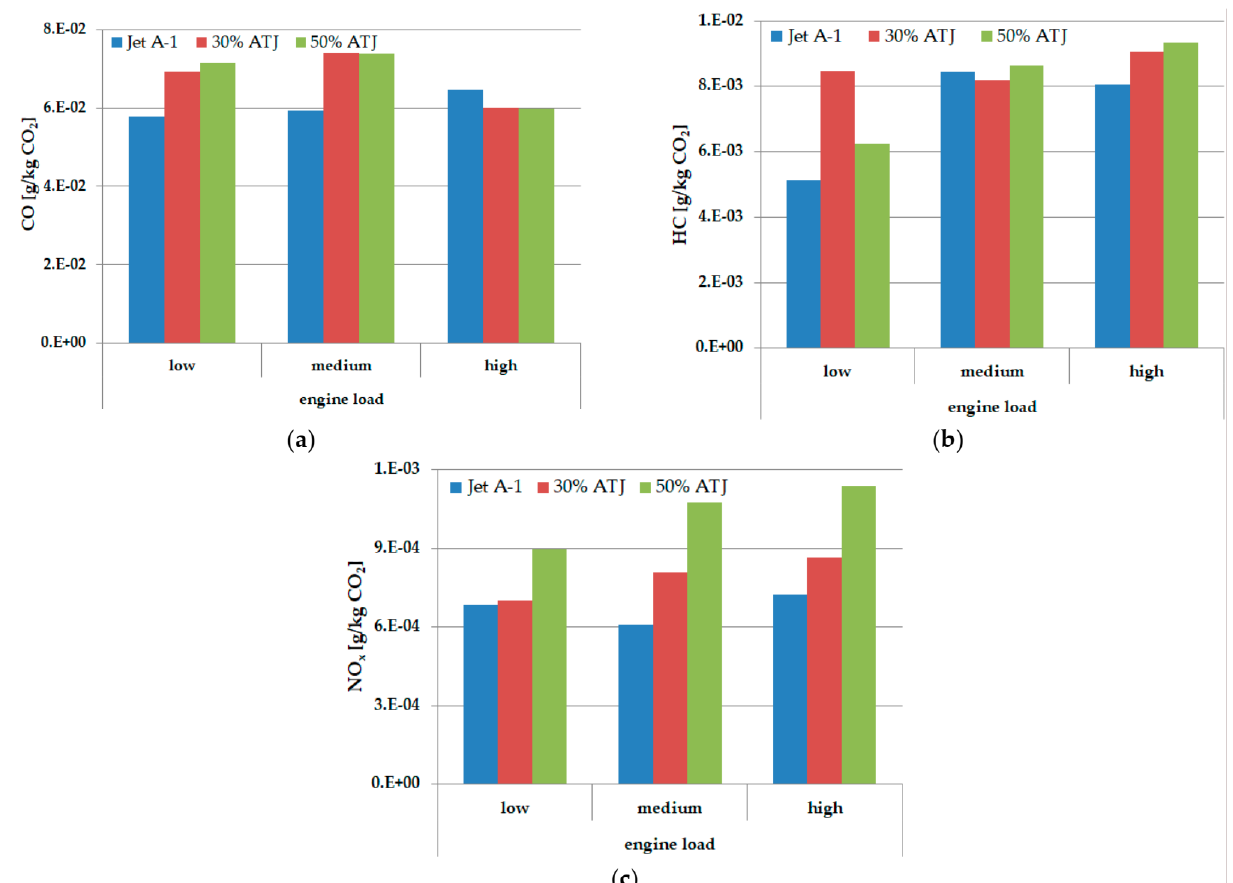
Figure 3. Emission index for ( a ) carbon monoxide; ( b ) hydrocarbons; ( c ) nitrogen